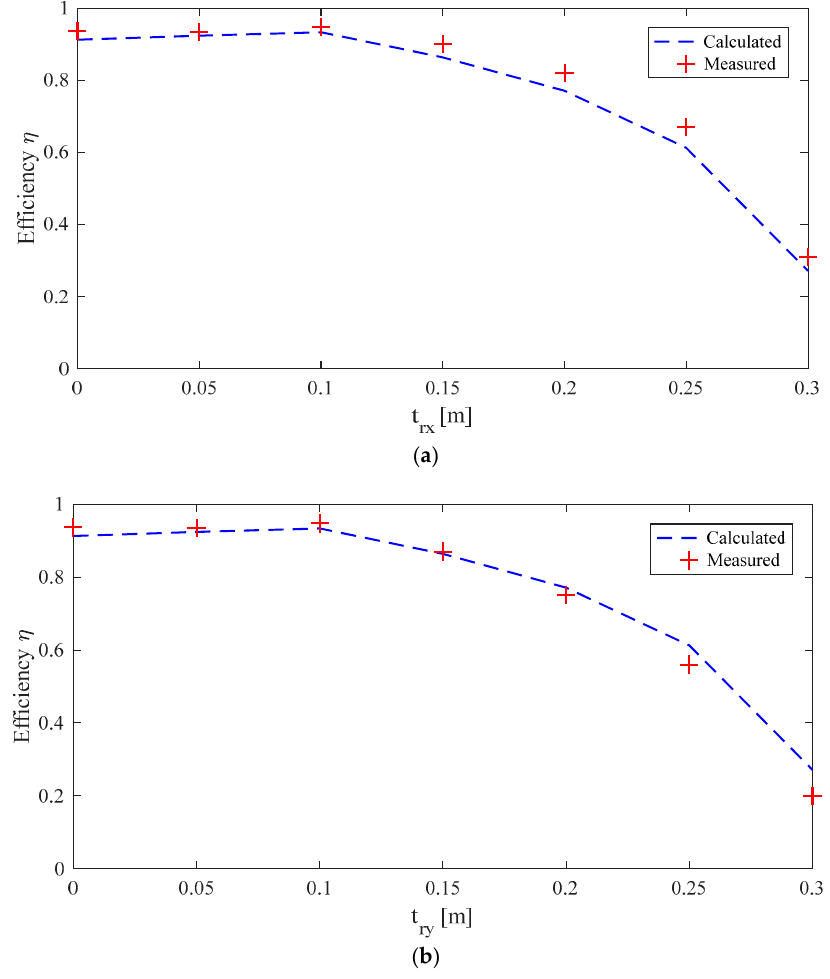
Figure 16. Calculated and measured efficiency η versus misalignments along x -axis ( a ) and y -axis ( b ).